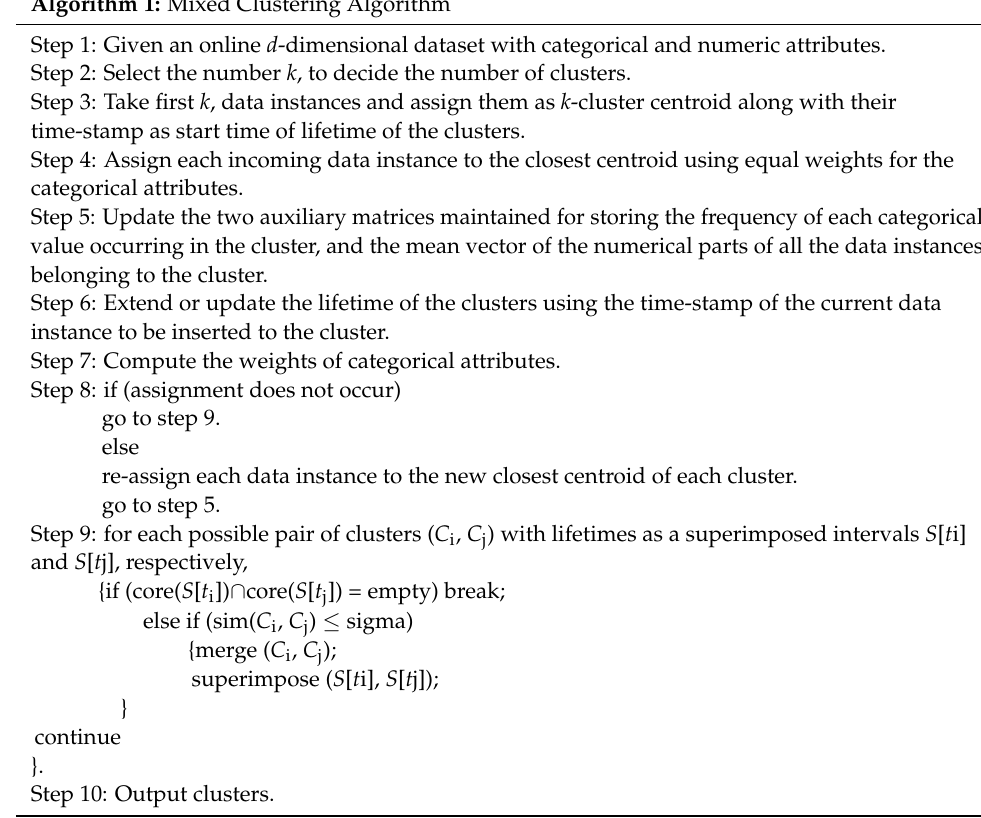
Algorithm 1: Mixed Clustering